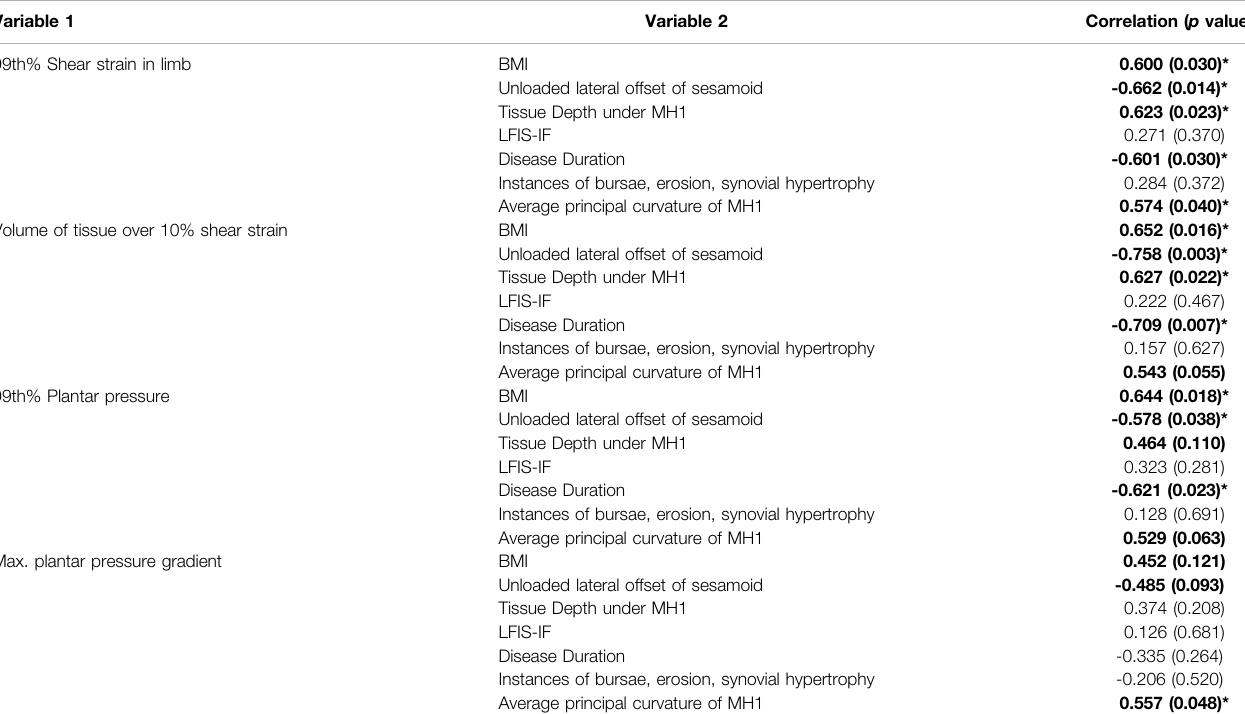
TABLE3| Correlationsformodelpredictionswiththeclinicaldataandmorphologicalmeasurements.Moderatetostrongcorrelations( > 0.4)arebolded.*indicatessigni fi cant ( p < 0.05) correlation. Variable 1 Variable